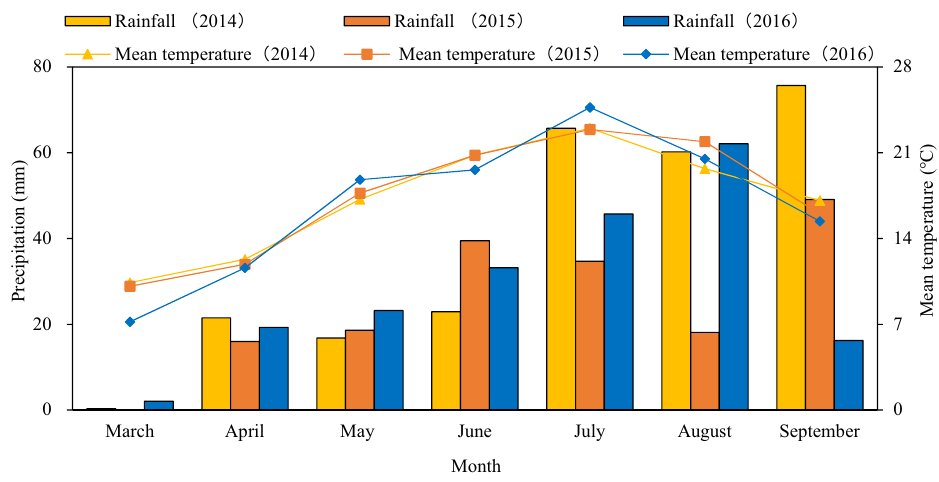
Figure 5. Monthly total precipitation and mean air temperature during the crop growth period in 2014, 2015, and 2016 at the Experimental station of Gansu Agricultural University in northwestern